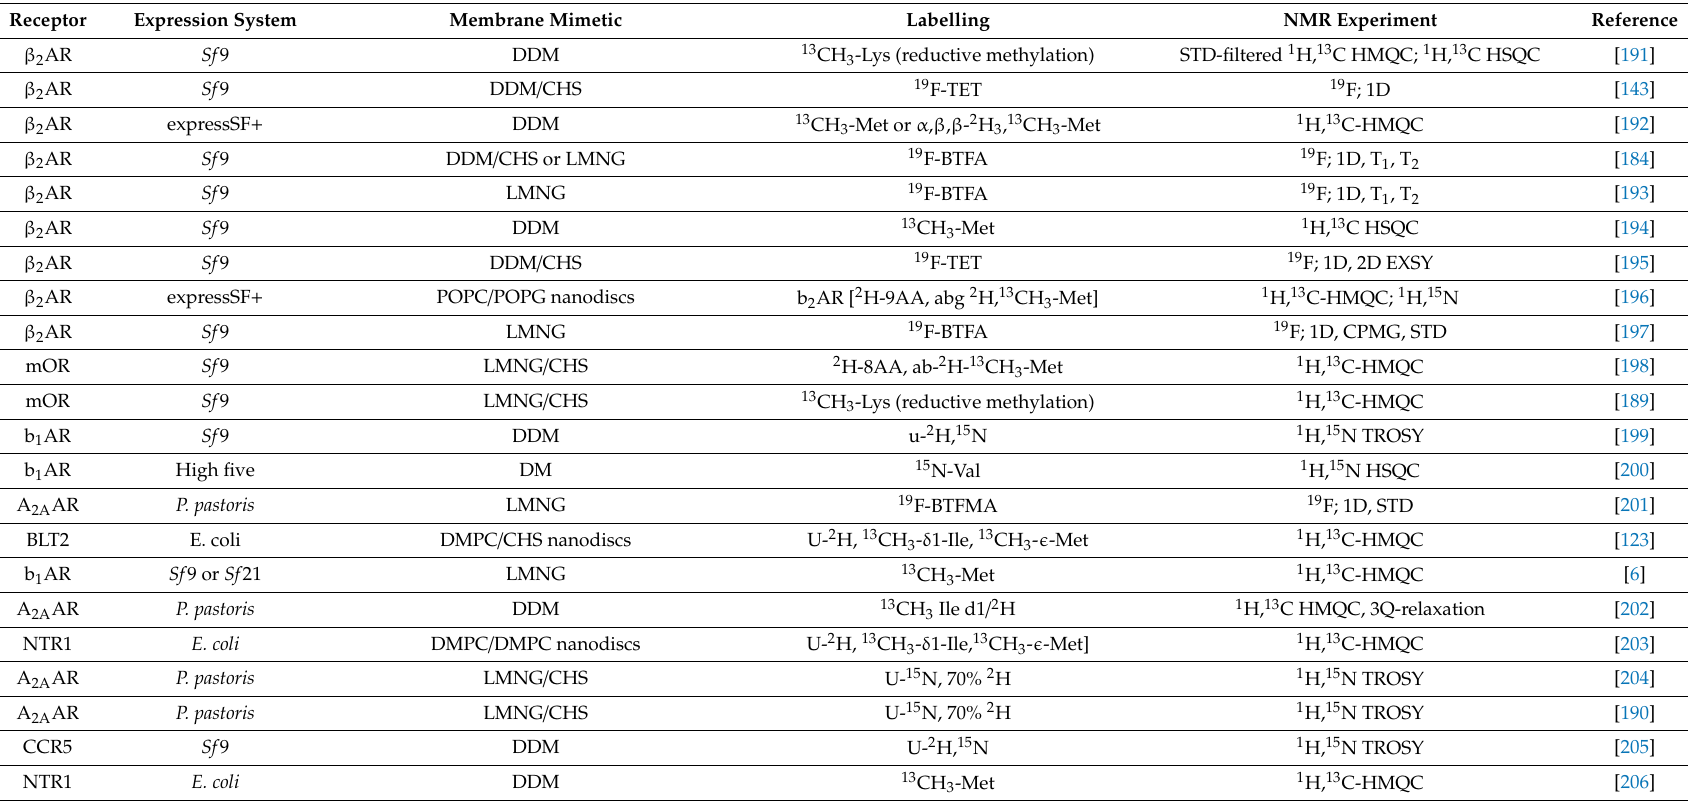
Table 2. Studies of GPCR conformational dynamics using solution-state NMR in conjunction with various membrane mimetics.